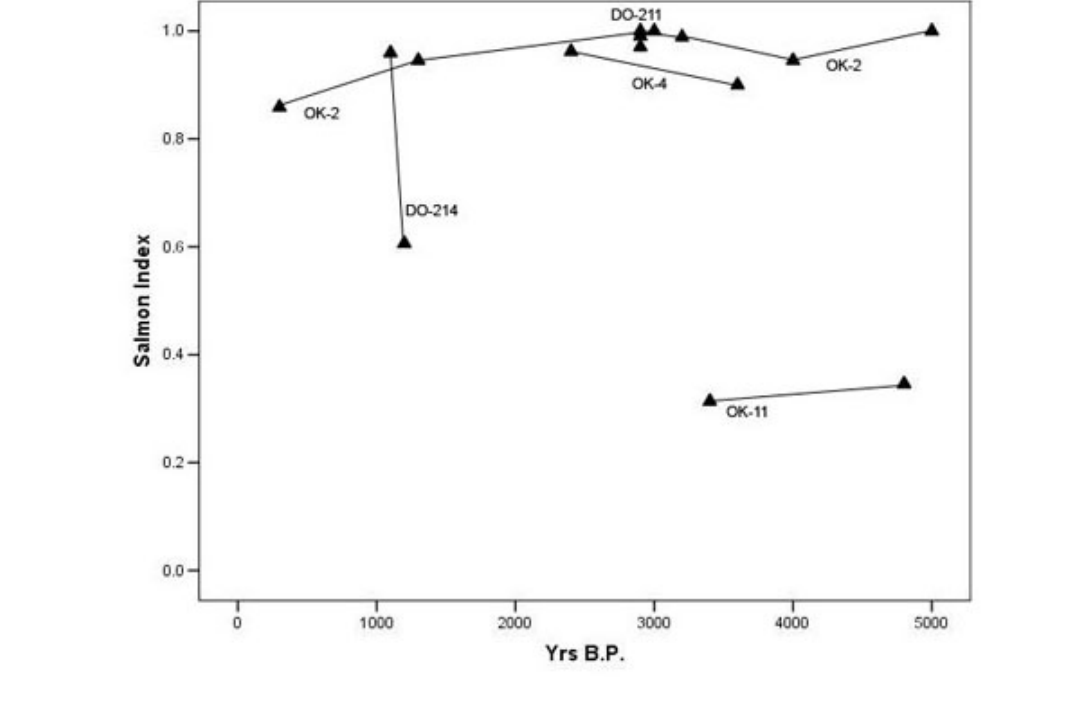
Fig. 4. Changing salmon ratios within sites with multiple occupations, northern Columbia Plateau (salmon index: frequency of salmon bones/frequency of all fish